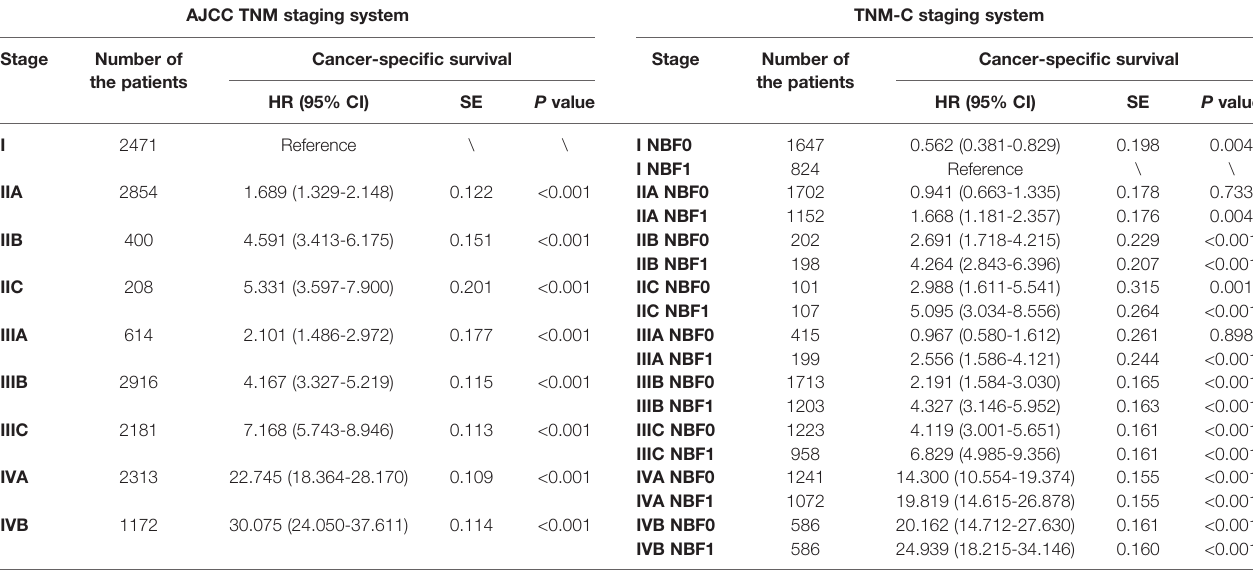
TABLE 4 | Prognosis of NBF-stage and TNM stage in patients before the recommended initiating colorectal cancer screening age. AJCC TNM staging system TNM-C staging system